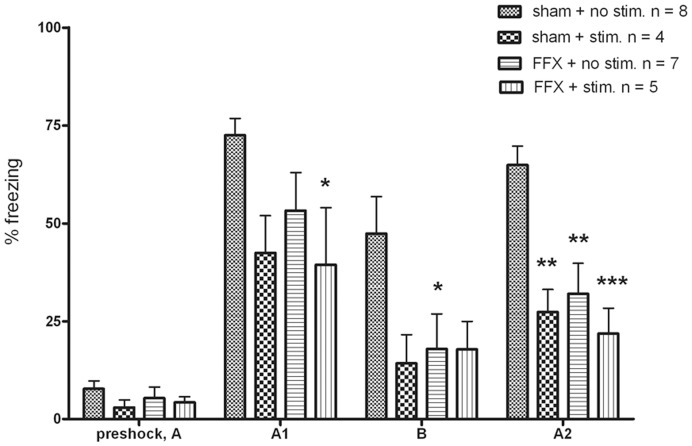
Freezing behavior expressed as percentage of time spent freezing during 5 minutes in the contexts used in the experiment; preshock, the conditioning chamber (A), the novel chamber (B) and re-exposure to the conditioning chamber (A2).Dunnett’s two-sided post-hoc test was used to compare each test group with the non-stimulated sham group as a controlThe columns and error-bars represent mean ± SEM, * P<0.05, ** P<0.01, *** P<0.001.